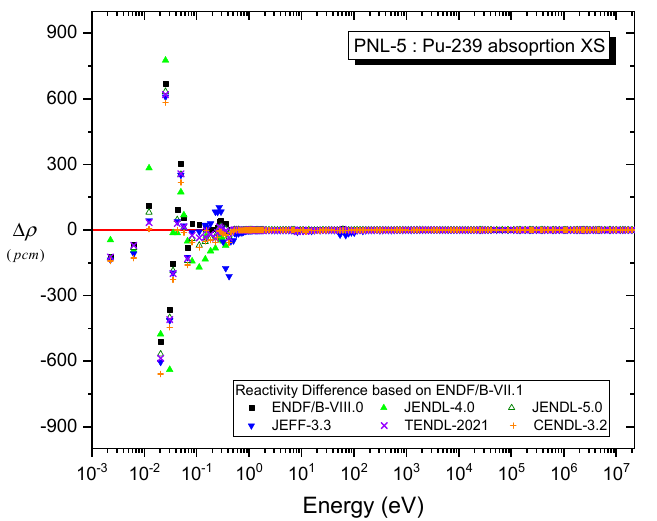
Figure 7. The reactivity difference due to the difference of 239 Pu absorption cross sections between ENDF/B-VII.1 and the other ENDL for PNL-5.